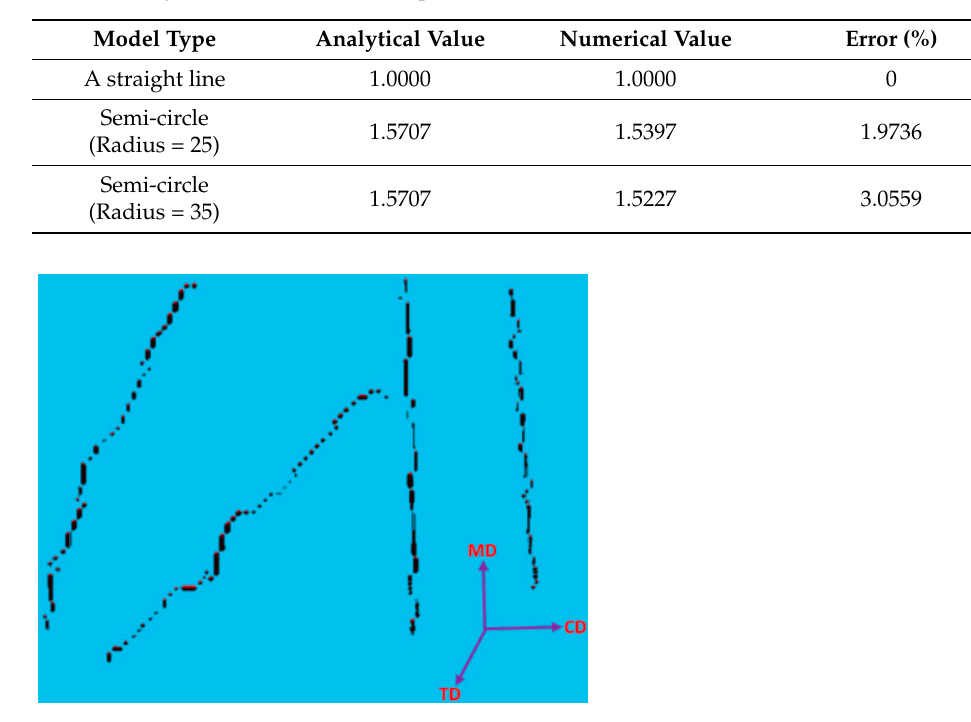
Figure 6. Skeletonized, small-size X ray µCT nonwoven model with four fibres.